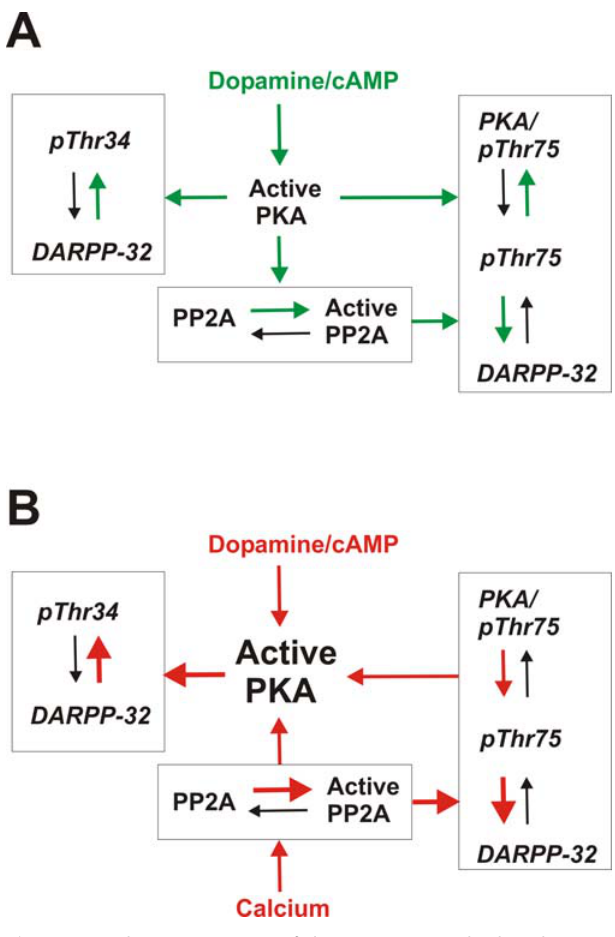
Figure 10. Schematic Drawing of the Reactions Involved in the PKA– PP2A–phosphoThr75 Loop When dopamine stimulates PKA, a substantial amount of the free catalytic subunit gets bound to PP2A and phosphoThr75, thus damp- ening the stimulatory effect of dopamine on PKA (A). Calcium stimulation and the formation of the calcium-activated PP2A affects this loop in two ways: 1) by increasing dephosphorylation of phosphoThr75, thus reducing inhibition of PKA; and 2) less PP2A is available for PKA binding, thus shifting this equilibrium to increase the amount of active PKA